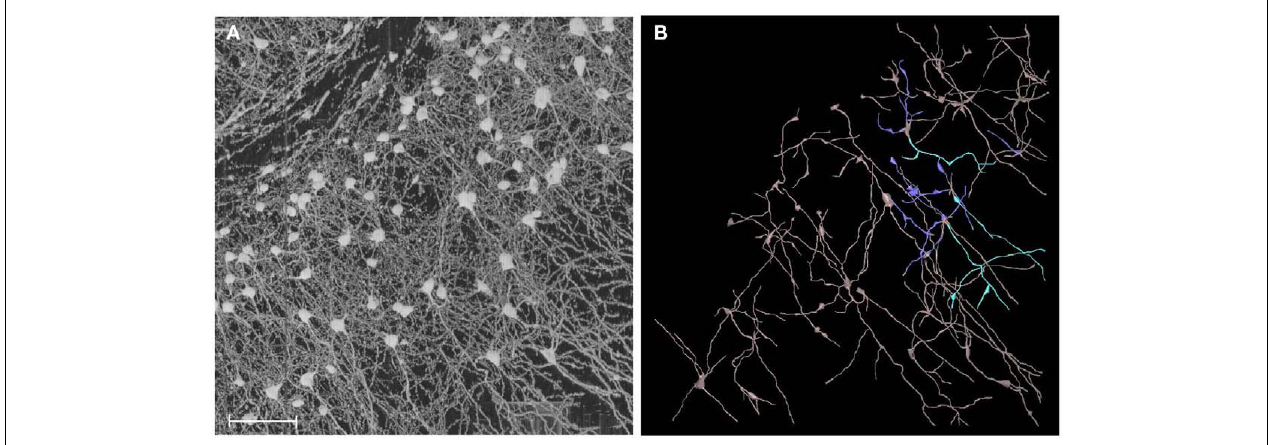
FIGURE 14 | From image to geometry. (A) A portion of KESM Golgi data set 1 is shown (cortex). Maximum intensity projection is used to show a thicker section containing a large number of neurons. Scale bar = 100 μ m. (B) Semi-automated 3D reconstruction results are shown (partial results, using Neuromantic, Myatt and Nasuto,